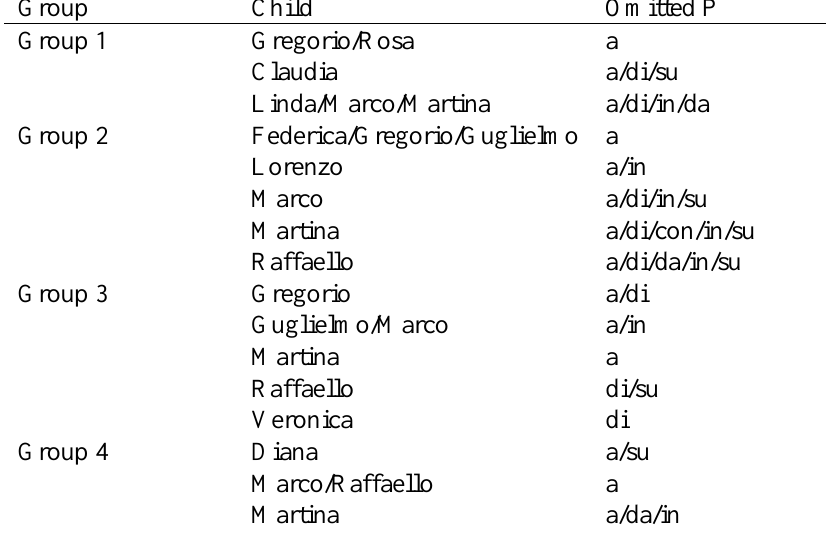
Table 10 . Omitted prepositions per child across MLU Groups